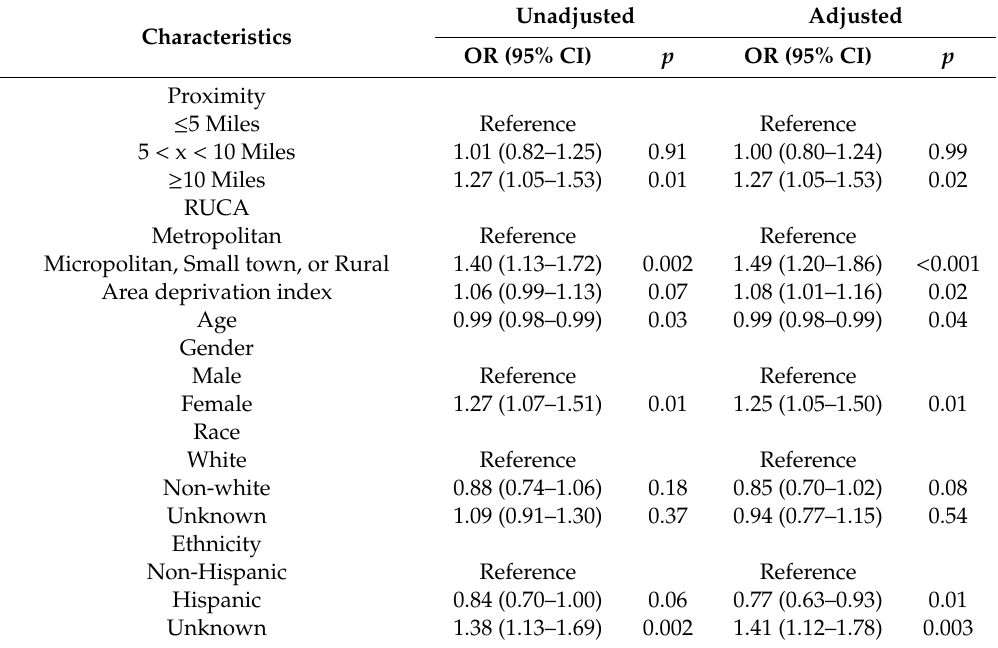
Table 2. Unadjusted and adjusted multilevel binary logistic regression analyses of characteristics associated with not receiving treatment in Yakima County, Washington between 2007 and